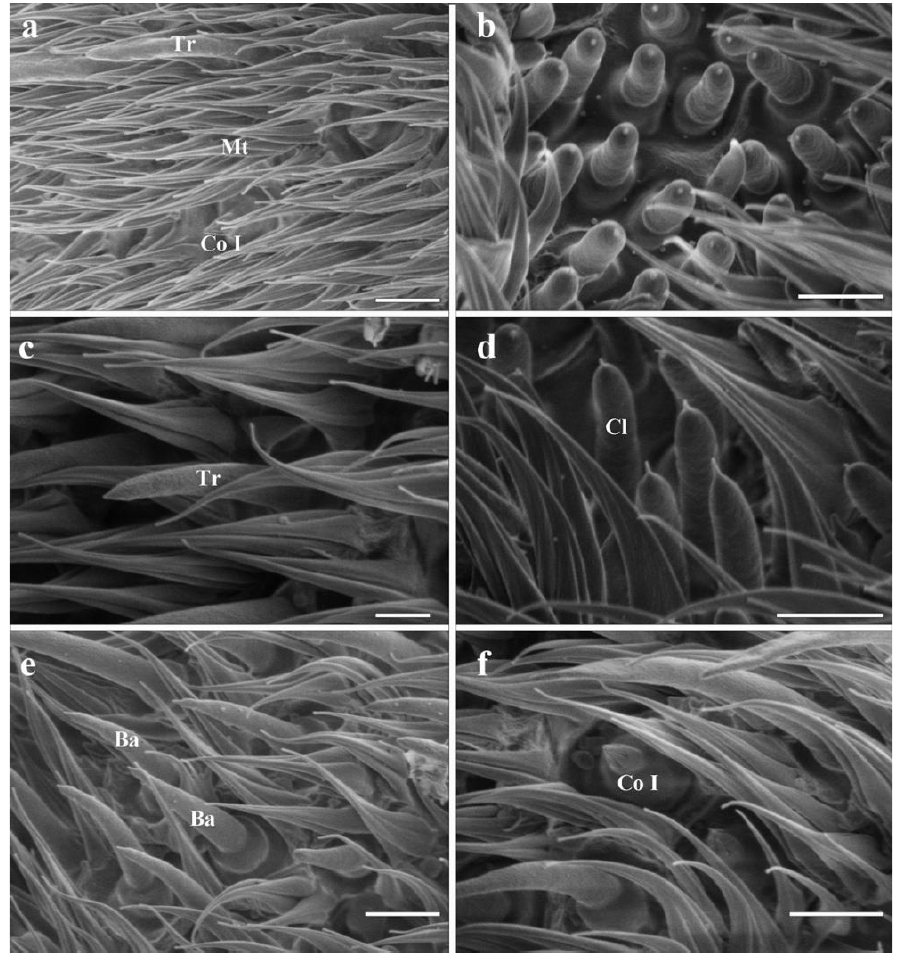
Figure 4. Scanning electron micrographs of sensilla on the postpedicel in male Gyrostigma rhinocerontis . ( a ) Distribution of sensilla on postpedicel surface. ( b ) Dorsal view of ‘super sensory pit’. ( c ) Trichoid sensillum. ( d ) Clavate sensilla clustered in sensory pit. ( e ) Basiconic sensilla. ( f ) Coeloconic sensillum I, set in shallow depression on postpedicel surface. Scale bars: ( a , b , d – f ) = 5 μm, ( c ) = 2.5 μm. Abbreviations: Ba, basiconic sensillum; Co I, coeloconic sensillum I; Cl, clavate sensillum; SP, sensory pit; Tr, trichoid sensillum.